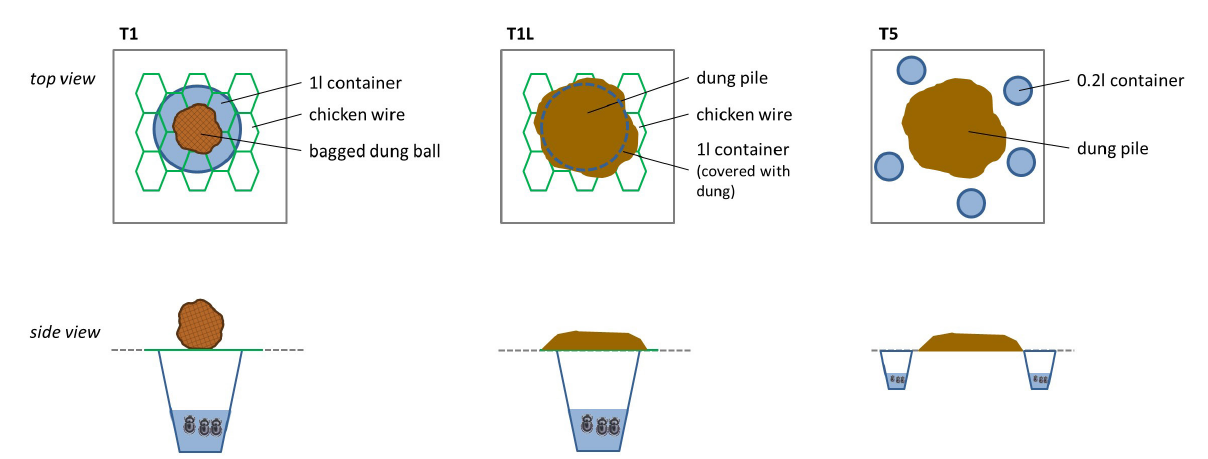
Figure 4. Schemes of the used trap types: 1 large pitfall covered with a dung ball in a nylon bag (T1, left), 1 large pitfall covered with a large, unpacked dung pile (T1L, middle), and 5 small pitfalls surrounding a central dung pile (T5, right). For each of the trap types a top view and a side view is